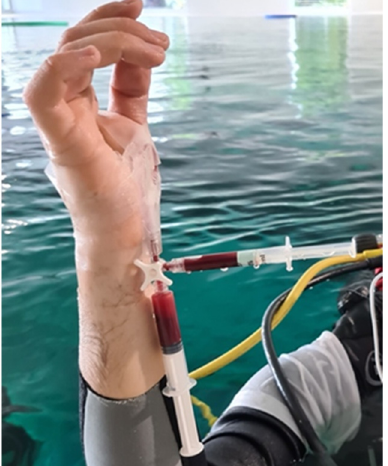
Figure 2. Third arterial blood sample at the surface. The heparinized syringe (pointing rightward) was analyzed to compare partial pressure of oxygen with ORi™ values. The syringe pointing downward was only used to draw initial blood and then flush the line (dead space syringe) and was, therefore, discarded.